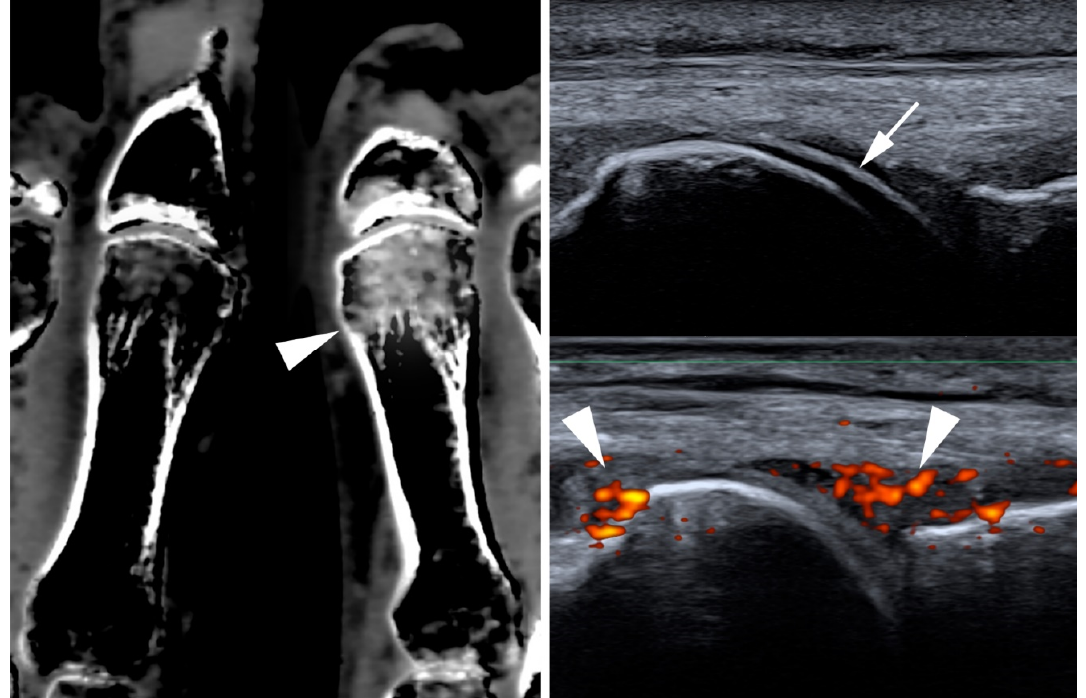
Figure 2. Multimodality imaging for gout. ( Left ): Virtual calcium subtraction imaging from dual-energy computed tomography. The arrowhead indicates bone marrow edema in the first metacarpal head. ( Right ): Ultrasound image of the same patient. The arrow indicates double-contour sign and arrowheads indicate synovitis on the power Doppler.